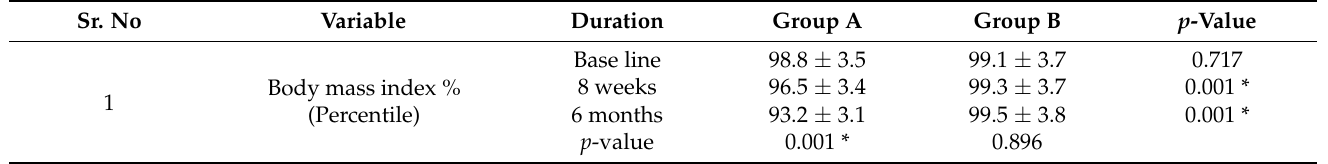
Table 2. Pre and post primary and secondary outcome measures of Group A and